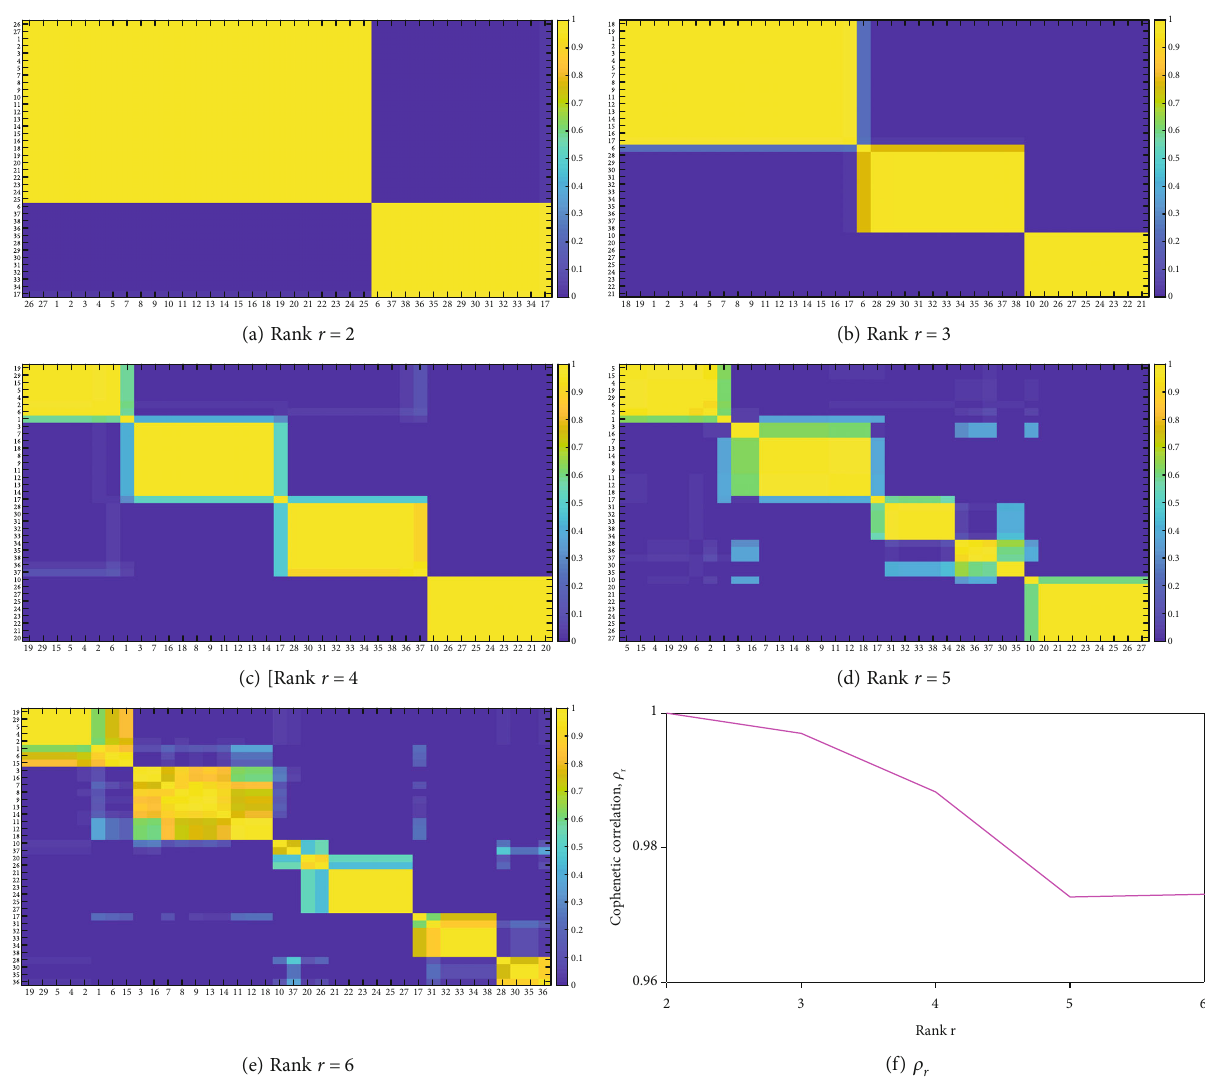
Figure 4: KL-NMF: (a – e) reordered consensus matrices obtained by averaging 50 connectivity matrices and (f) cophenetic correlation coe ffi cient ρ r for r = 2 ‐ 6 using